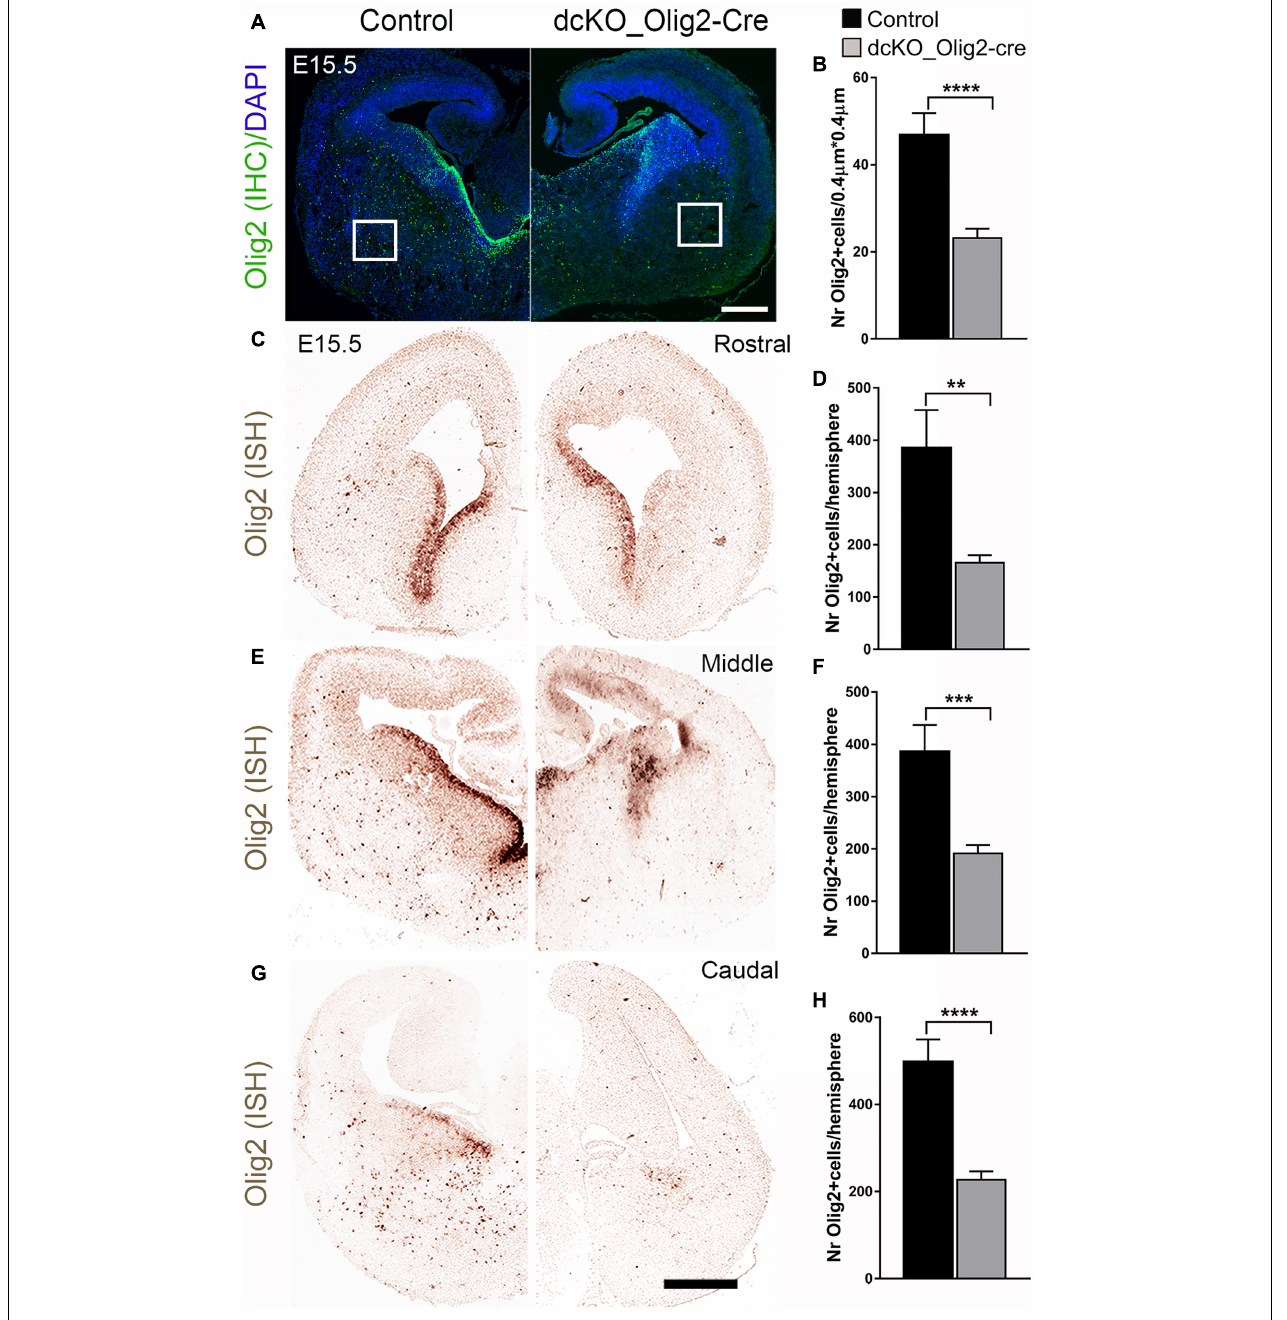
FIGURE 3 | Decrease in the number of Olig2-expressing cells due to loss of BAF155 and BAF170 in ventral telencephalon. (A,B) Immunohistochmical micrograph (A) and quantitative analyses (B) indicating diminished number of Olig2 + cells caused by loss of BAF155 and BAF170. (C,E,G) In situ hybridization micrographs using Digoxigenin-labeled Olig2 RNA probes in the control and dcKO_Olig2-Cre E15.5 mouse telencephalon along the rostral–caudal axis. (D,F,H) Statistical analyses indicate significant depletion of Olig2 + cells in the rostral middle, and caudal levels of the dcKO_Olig2-Cre mutant telencephalon compared with control. Data are expressed as means ± SEMs. Experimental replicates ( n ) = 6; ** p ≤ 0.01, *** p ≤ 0.001, **** p ≤ 0.0001. Scale bars = 200 µ m (A) , 100 µ m (D) .